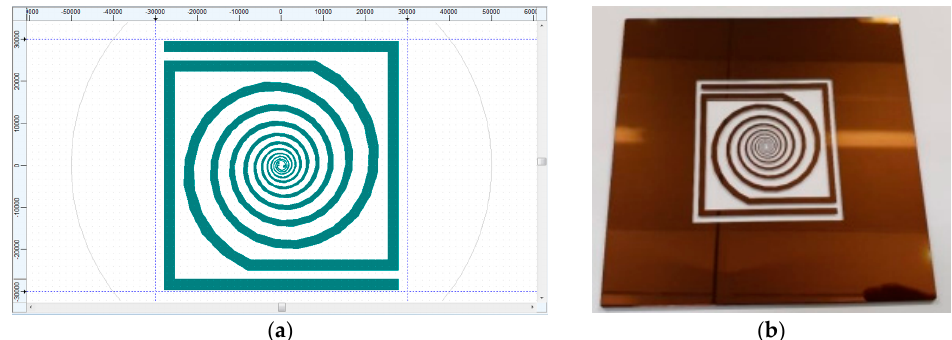
Figure 8. ( a ) Layout and ( b ) photolithographic mask of the RFID elements (antenna and symmetric attenuation network).